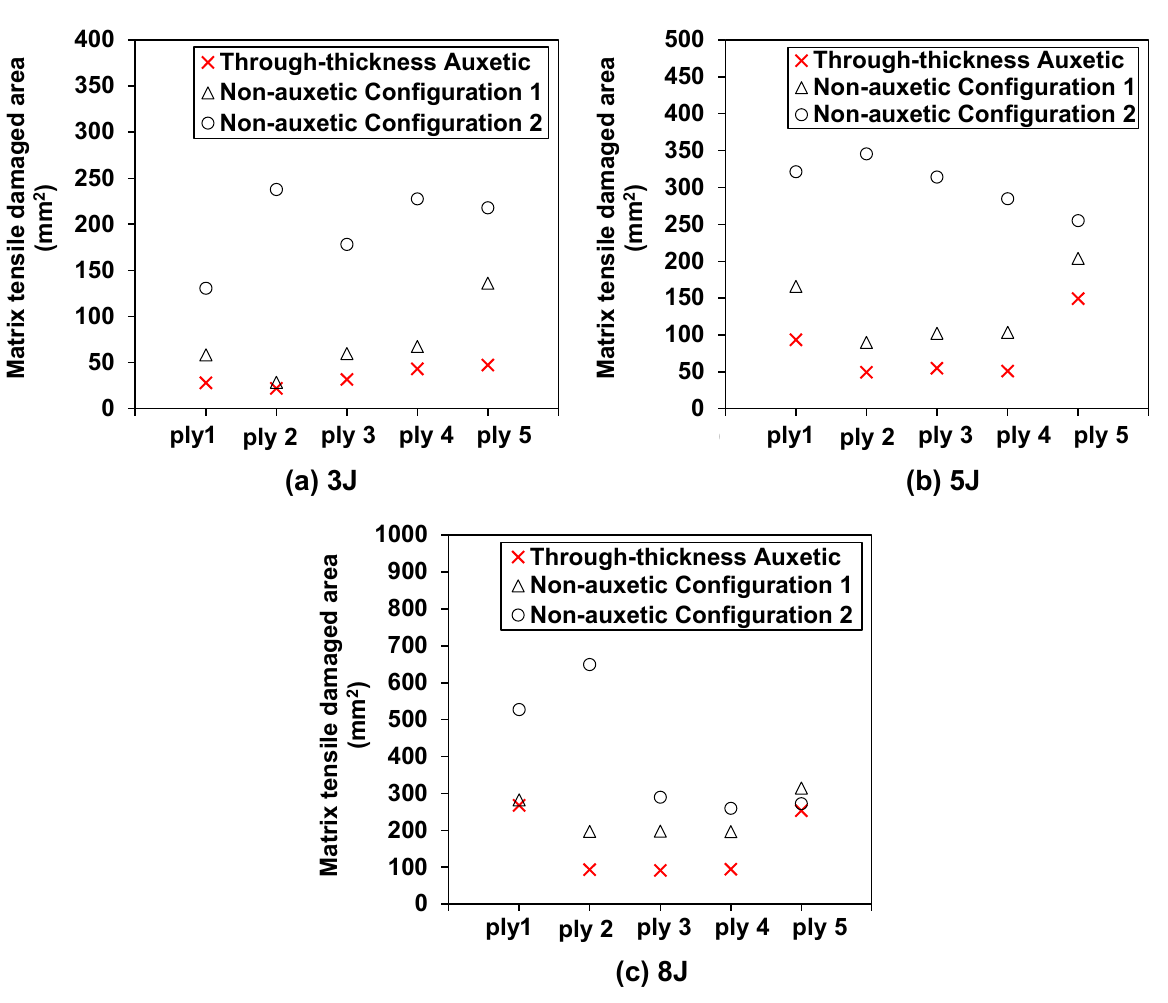
Figure 10. Effect of the through-thickness negative Poisson’s ratio on the matrix tensile damage: comparison of the predicted damage area in each ply of the auxetic and non-auxetic CFRP composite laminates at: ( a ) 3 J, ( b ) 5 J, and ( c ) 8 J.